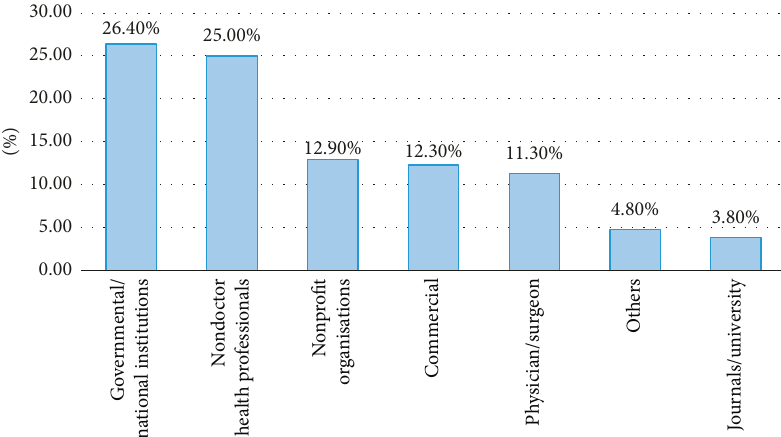
Figure 2: Rates of HON accreditation for various types of